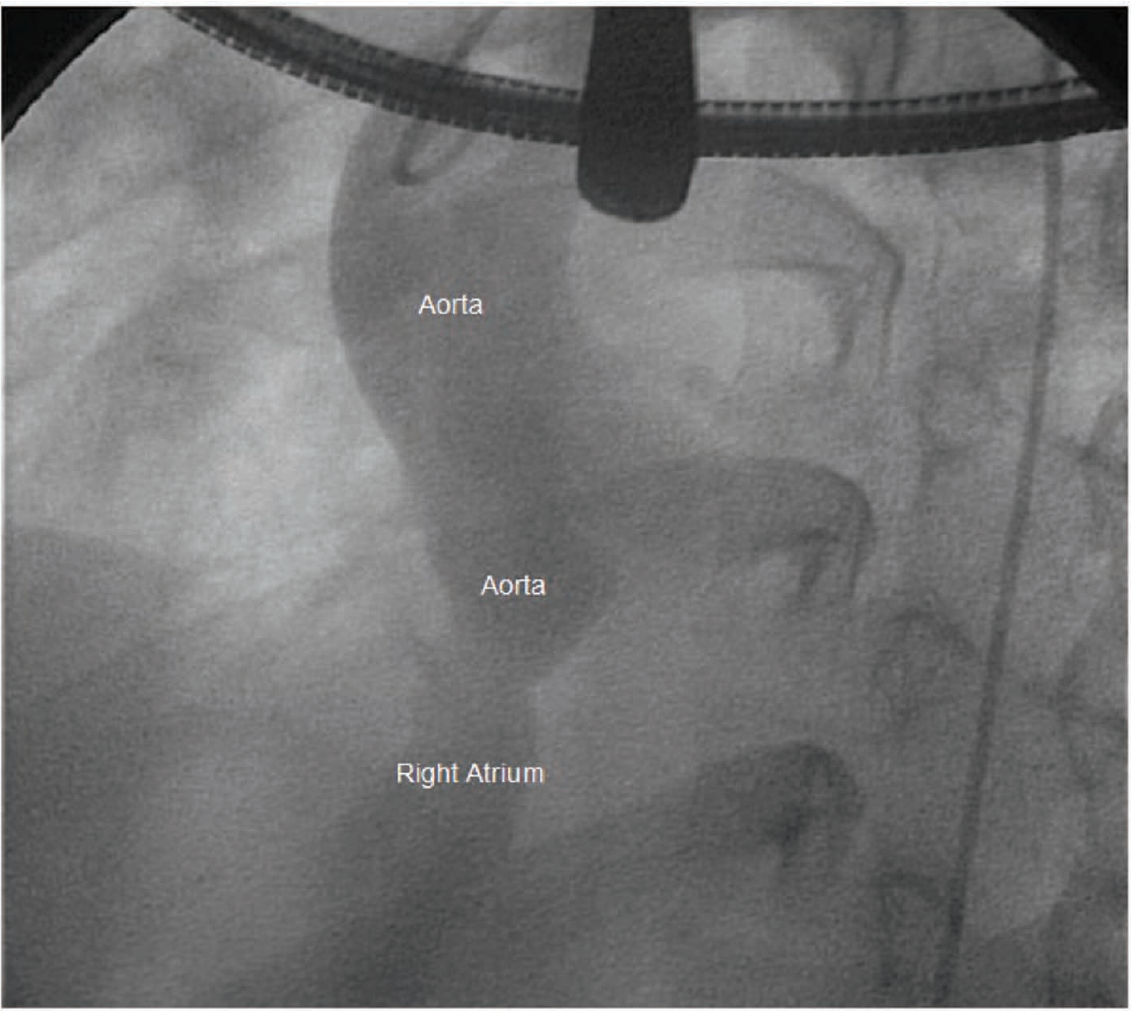
Figure 1. The aortogram showing contrast dye filling the right atrium through the ruptured sinus of Valsalva fistulous